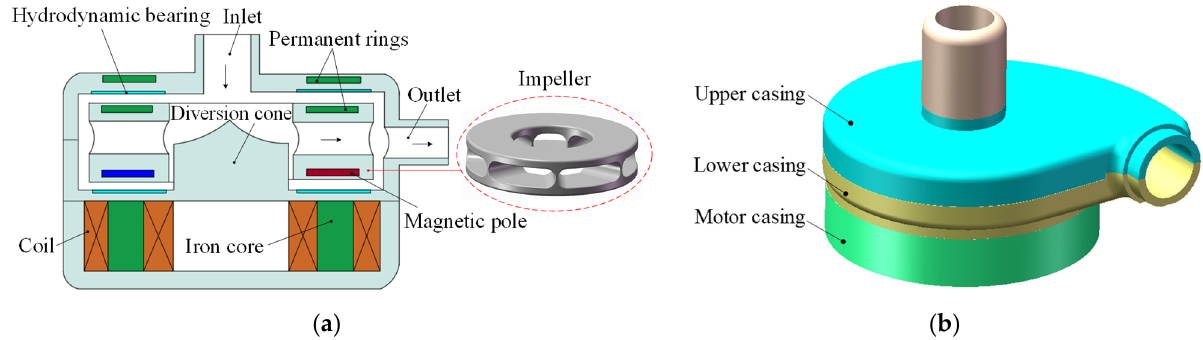
Figure 1. Magnetic–hydrodynamic hybrid suspension blood pump: ( a ) Structural composition of the blood pump; ( b ) Three-dimensional casing model.